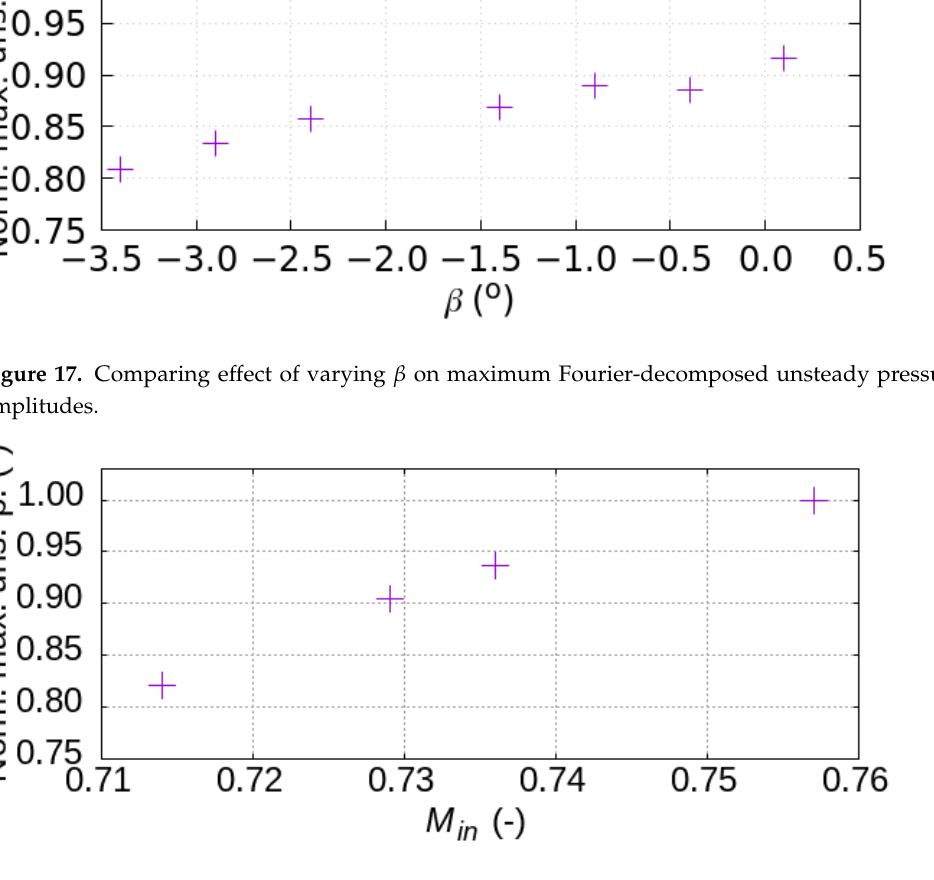
Figure 18. Comparing effect of varying M in on maximum Fourier-decomposed unsteady pressure